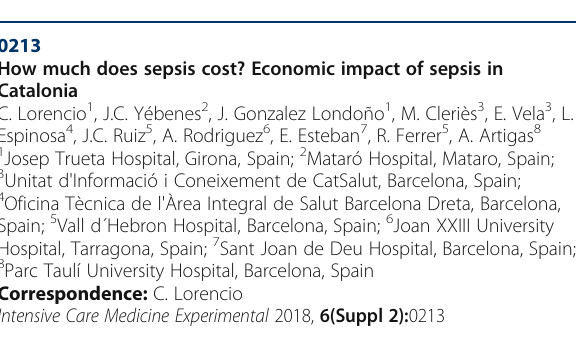
Table 3 (abstract 0212). Continuous equivalent sound pressure ( LAeq,perday ) during weekdays LAeq,perday